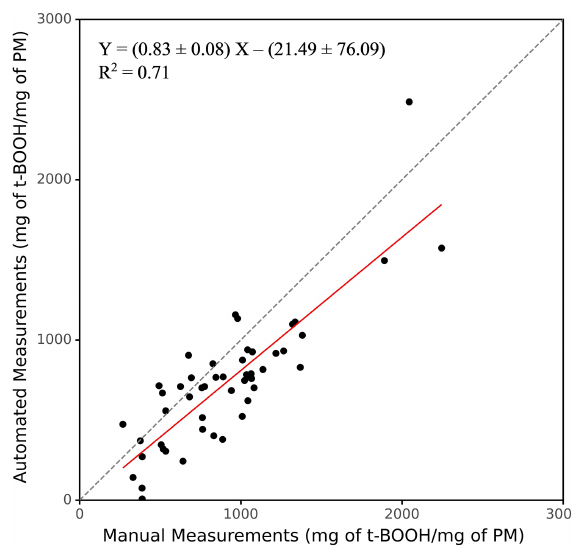
Figure 5. Comparison of the OP for manual vs. automated oper- ation using ambient PM samples ( N = 50). Dotted line represents the identity